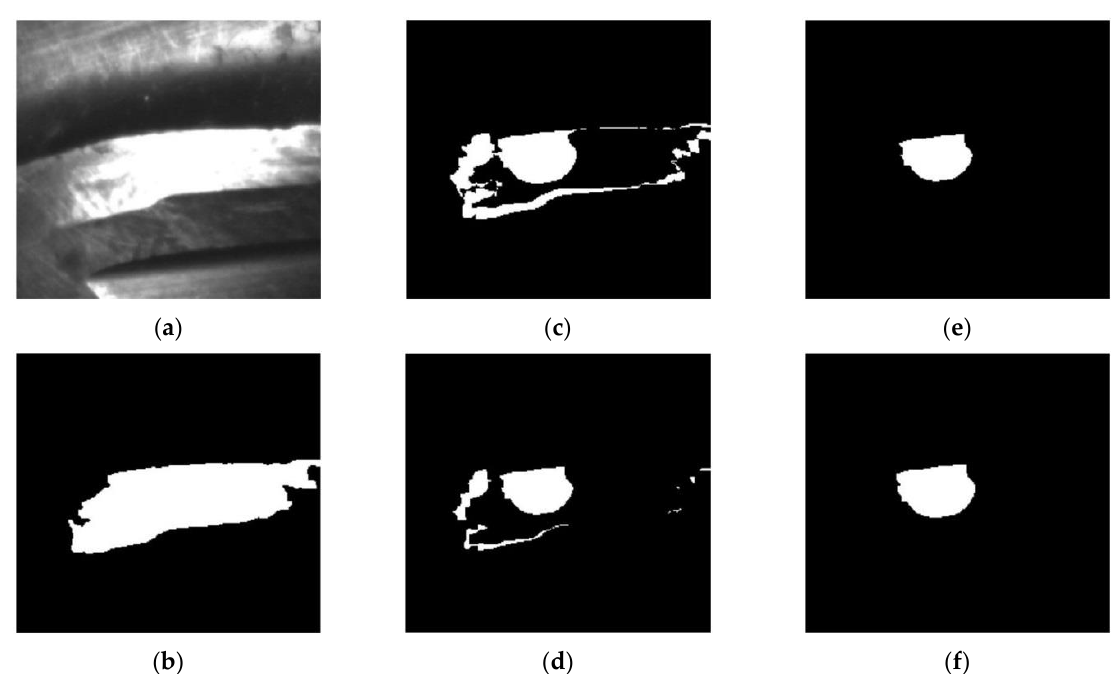
Figure 7. Wear region extraction of flank face image: ( a ) Unmachined flank face; ( b ) Processed unmachined flank face. Morphological operations of ( c ) subtracted, ( d ) erosion, ( e ) extraction of largest connected component and ( f ) expansion.